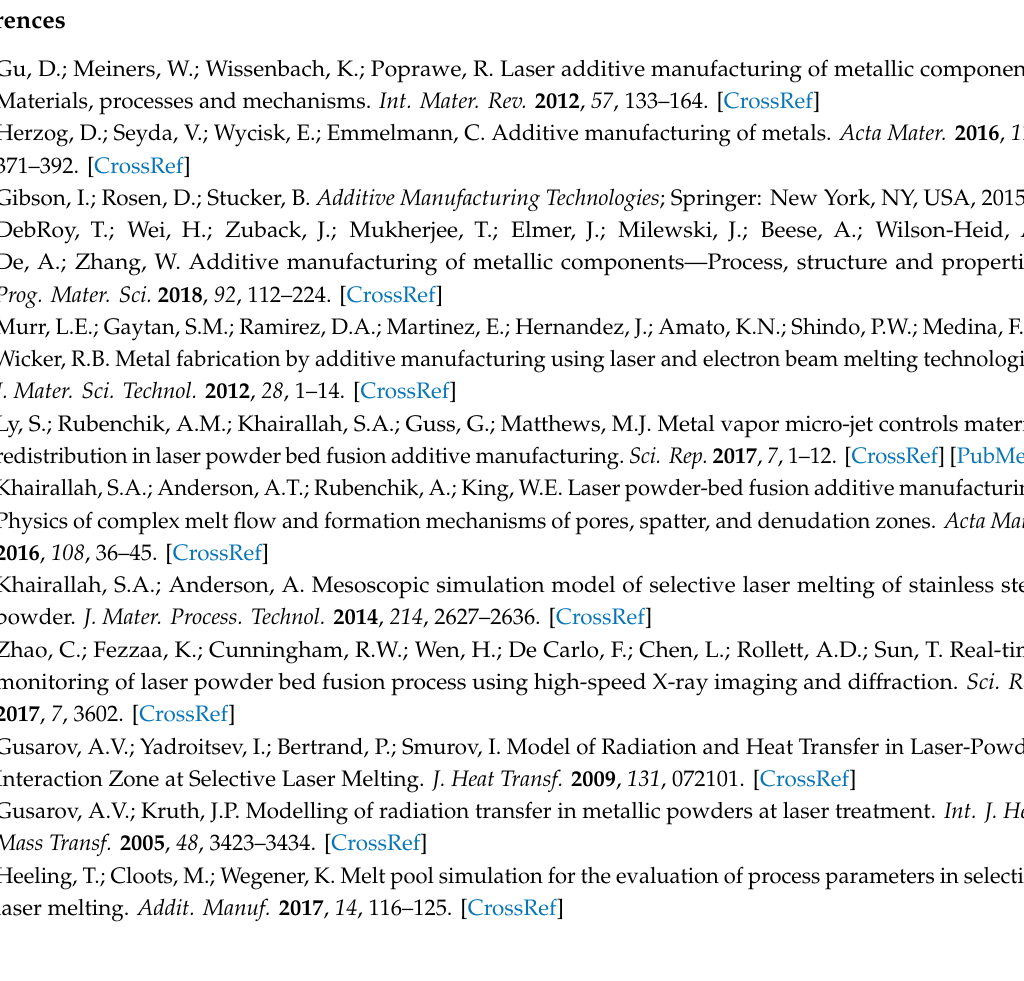
Figure A2. Standard deviation of the Cr content from di ff erent process parameters as a function of E h o , the volumetric energy density calculated based on the hatch spacing.